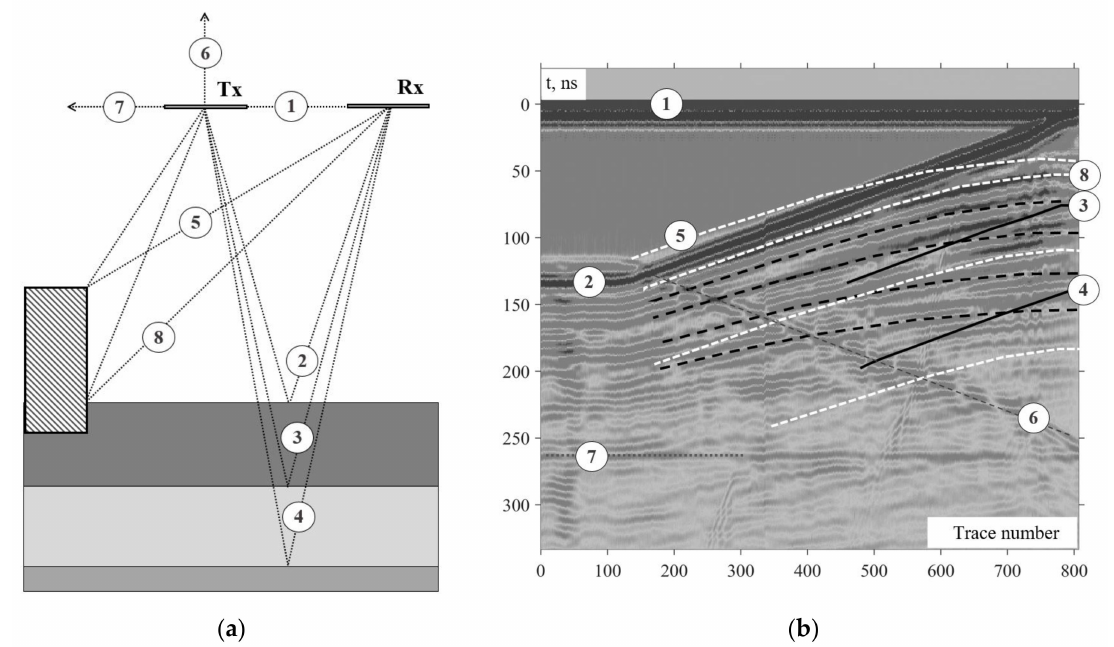
Figure 3. GPR probing with a gradually descending in-line antenna set: ( a ) Experiment geometry; ( b ) Results of GPR probing, B-scan, with overlapped simulation plots, Figure 4, denoted by lines. Symbolic notation used for all figures here and below in Section 3: ( 1 ) direct wave; ( 2 ) reflected wave from the ground surface; ( 3 ) reflected wave from an interface at a depth of 2.5 m, solid black line; ( 4 ) reflected wave from the interface at a depth of 4 m, solid black line; ( 5 ) diffracted wave from the building corner, white dashed line in ( b ); ( 6 ) reflected wave from the crane boom; ( 7 ) reflected wave from the vertical crane tower, dotted gray line; ( 8 ) signals from the wall-ground bound line, black dashed line in ( b ). Notation: Tx—transmitter;